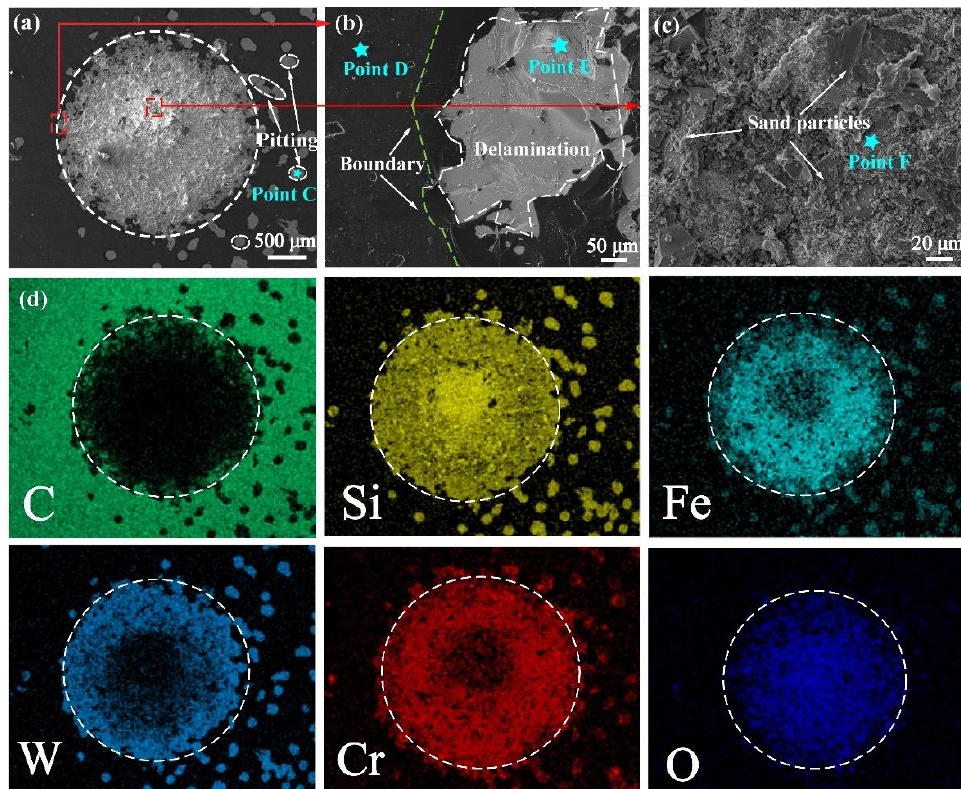
Figure 10. Wear scar topography and elemental distribution of Cr/W-DLC/DLC multilayer films at RT under the sand condition: ( a – c ) wear scar topography; ( d ) elemental distribution.